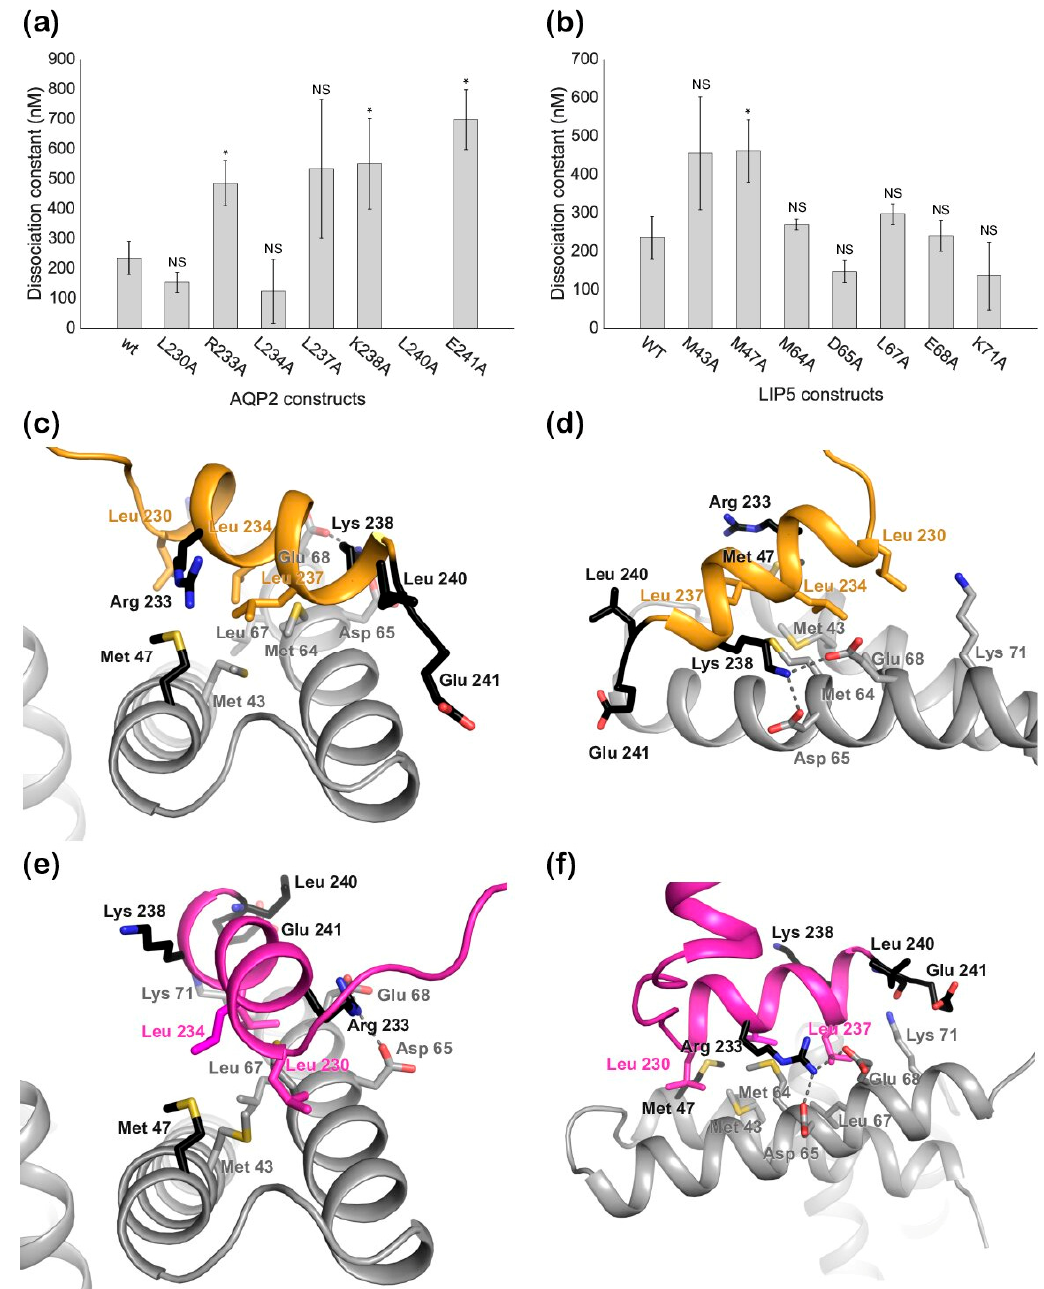
Figure 5. Mutational analysis of the best HADDOCK docking solutions. Bar charts showing the dissociation constants (K d ) for the interaction between ( a ) LIP5 and AQP2 wild-type/mutants and ( b ) AQP2 and LIP5 wild-type/mutants. * indicates p < 0.05 ( n = 3), NS indicates no significance; ( c ) and ( d ) structural representation of the interaction sites in cluster 2; ( e ) and ( f ) Structural representation of the interaction sites in cluster 3. Mutated residues which lower the affinity of the interaction or abolish it completely are shown in black. All residues that were probed by mutation are shown in stick representation. Predicted hydrogen bonds are depicted as dotted lines.